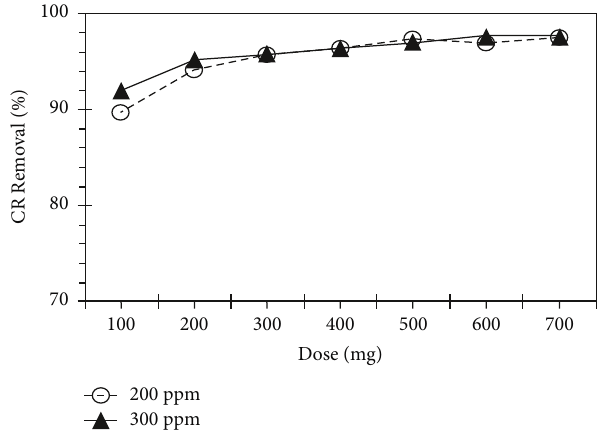
Figure 3: Effect of adsorbent dosages on adsorptive removal of Congo red by using fish bone powder (FBP) (adsorbate volume: 100mL, pH: 2; adsorbate concentration: 200, 300mg · L − 1 ; contact time: 4.0h).